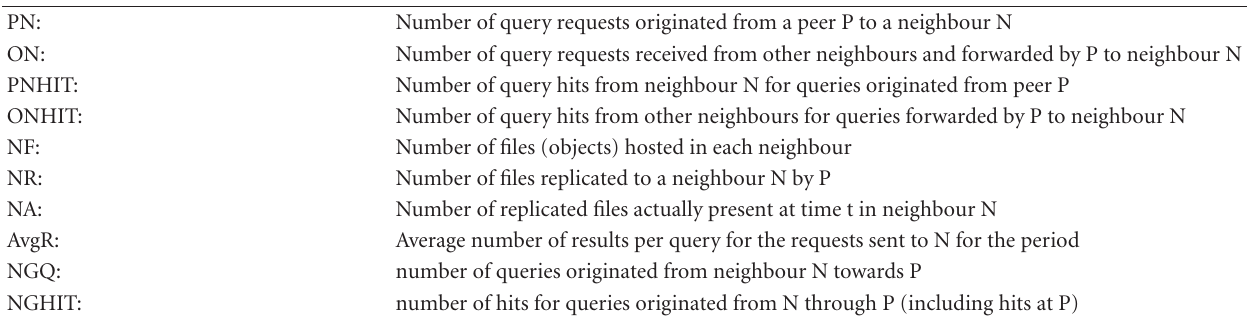
Table 2: Parameters collected from a neighbour in the normal